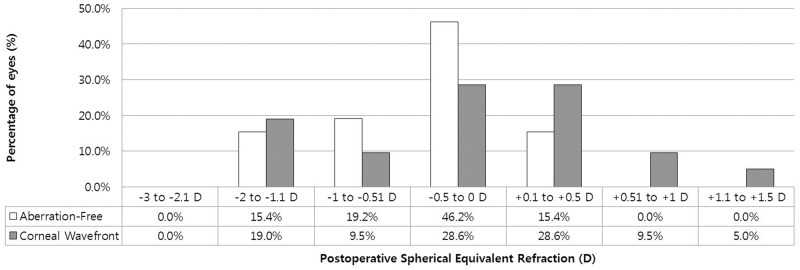
Distribution of the postoperative spherical equivalent (predictability) in the sample of myopia or myopic compound astigmatism eye undergoing laser-assisted in situ keratomileusis with six-dimensional Amaris laser platform.